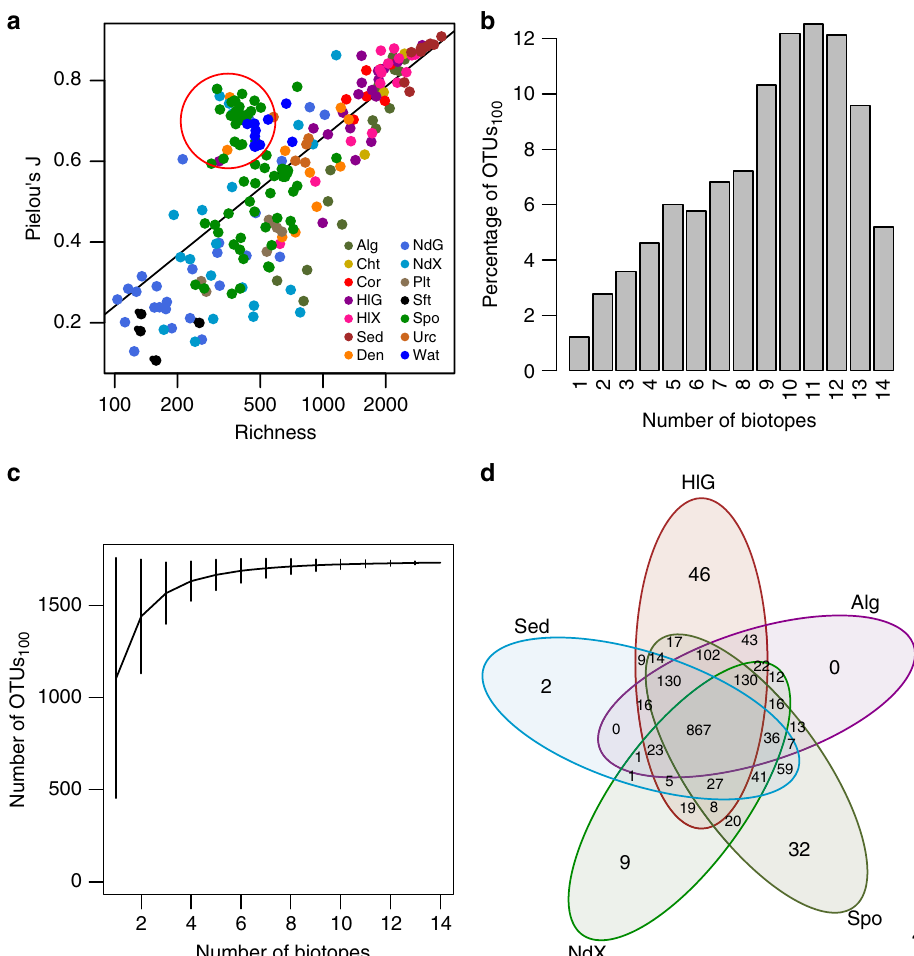
Fig. 5 Diversity components and distribution of OTUs among biotopes. a Relationship between richness and evenness. OTUs representing HMA sponges have been encircled in red. b Percentage of OTUs 100 recorded in from 1 to 14 biotopes. For example, 1.2% of OTUs 100 (21 OTUs 100 ) were recorded in one biotope, 2.8% (48 OTUs 100 ) in two biotopes, 3.6% (62 OTUs 100 ) in three biotopes and 5.2% (90 OTUs 100 ) in all 14 of the main biotopes. c Rare fi ed OTU richness (error bars represent 95% con fi dence intervals) as a function of the number of biotopes sampled and estimated using the specaccum function in vegan with the ‘ method ’ argument set to ‘ random ’ and 999 permutations. d Venn diagram, obtained using the vennCounts and vennDiagram functions of the limma package in R, showing the number of OTUs shared among the following fi ve biotopes: algae (Alg), holothurian gut (HlG), sponges (Spo), sediment (Sed) and nudibranch mantle (NdX). Source data are provided as a Source Data fi